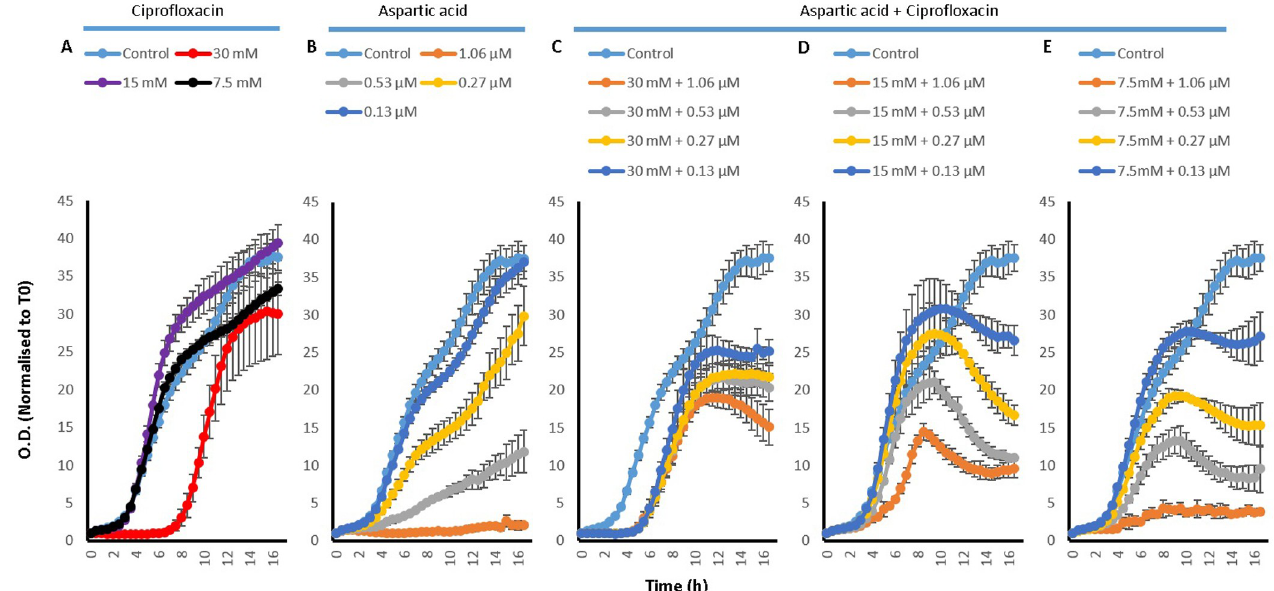
Fig 7. P . aeruginosa growth curves with A) 30, 15 and 7.5 mM L-Asp amino acid on its own, B) with 1.06, 0.53, 0.27 and 0.13 μ M Cip on its own, C) 30 mM L-Asp combined with 1.06, 0.53, 0.27 and 0.13 μ M Cip, D) 15 mM L-Asp combined with 1.06, 0.53, 0.27 and 0.13 μ M Cip and E) 7.5 mM L-Asp combined with 1.06, 0.53, 0.27 and 0.13 μ M Cip; n = 3.